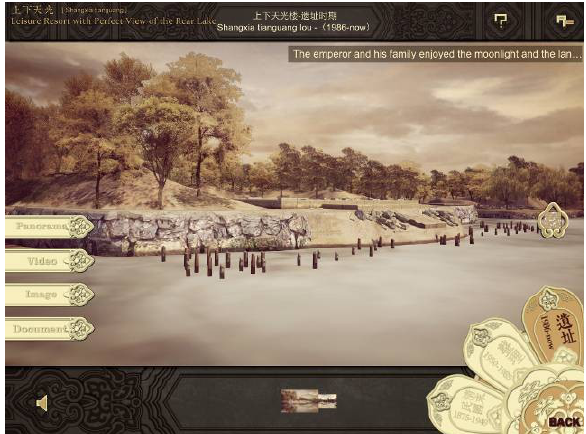
Figure 6. Full view of a scenic area (Shangxia tianguang) in the app, with red arrows showing view points of rendered images